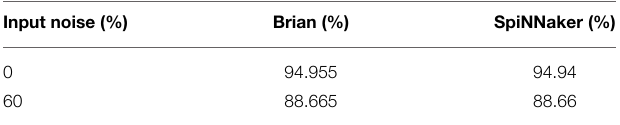
TABLE 2 | Classification accuracies for hardware and software simulations with limited bit precision, two different input noise levels, and input rates of